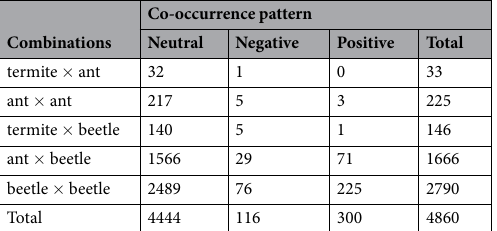
are primarily neutral or positive in nature, with negative interactions being significantly less common. It should be noted that this study was based on just one fire at a single site in the southeastern United States. The effects of fire on wood-dwelling insects are likely to vary greatly depending on a variety of site and fire-specific parameters